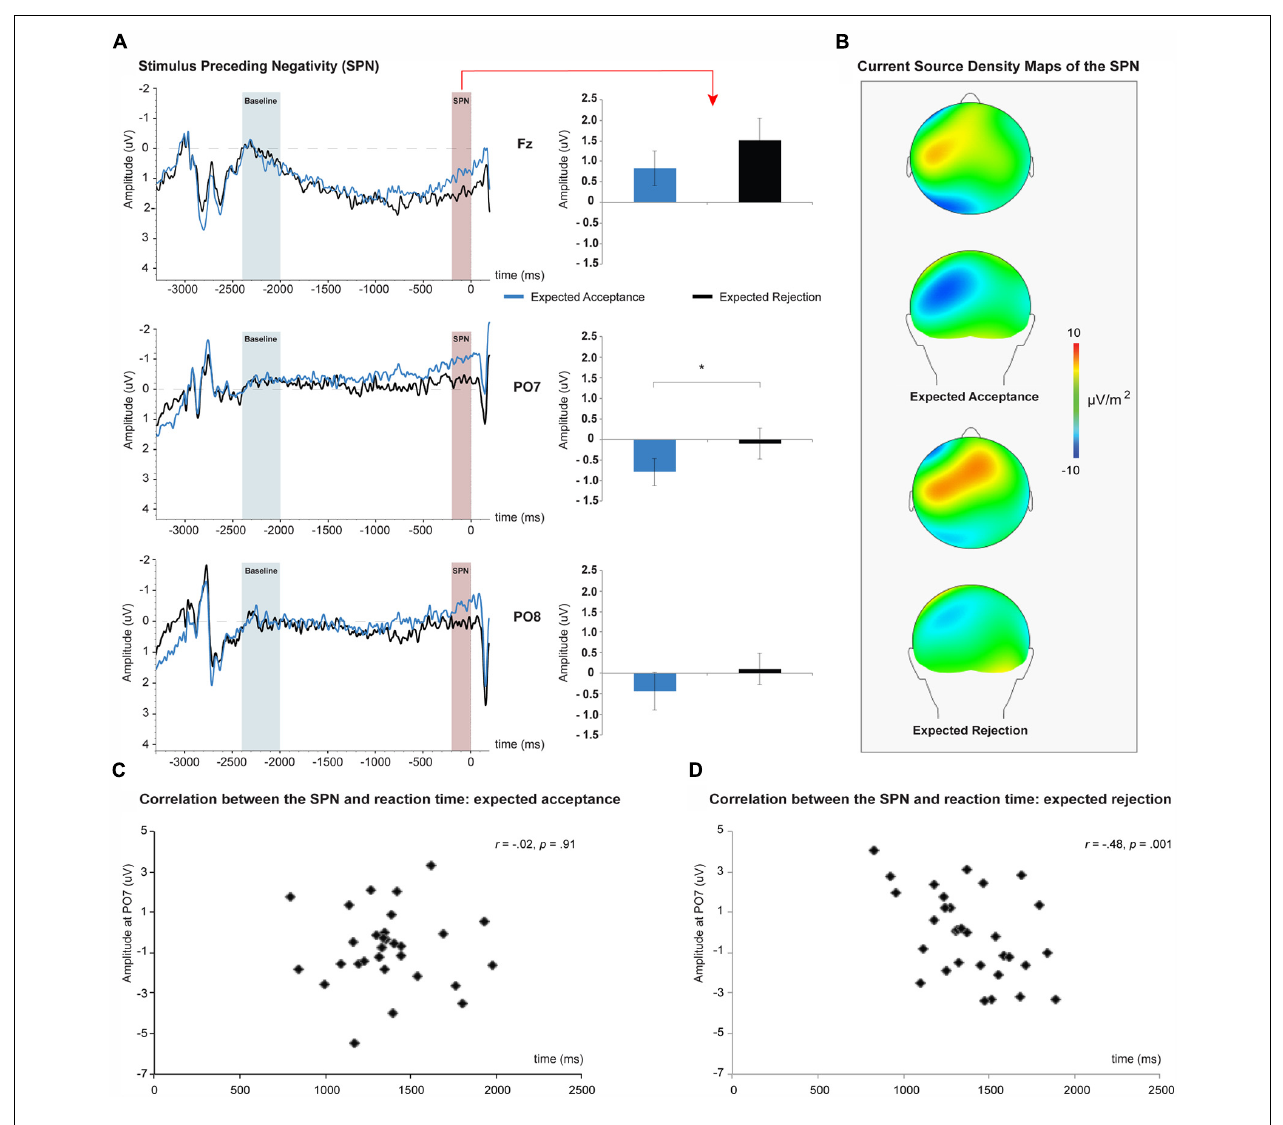
FIGURE 3 |The stimulus preceding negativity (SPN) associated with social-evaluative feedback anticipation. SPN amplitudes were larger for expected social acceptance than for social rejection, and reached peak amplitudes at PO7 (A) . Current source density maps show the left posterior dominance of the SPN (B) . Correlations